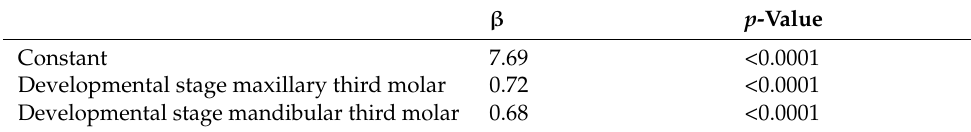
Table 2. Stepwise linear regression model. The constant as well as the included parameters (maxillary and mandibular developmental stage) were statistically